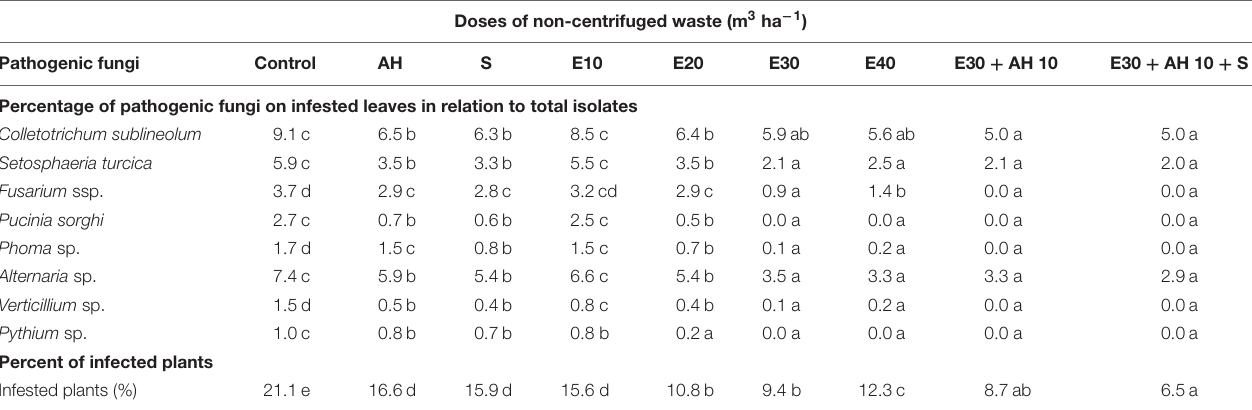
Verticillium sp.